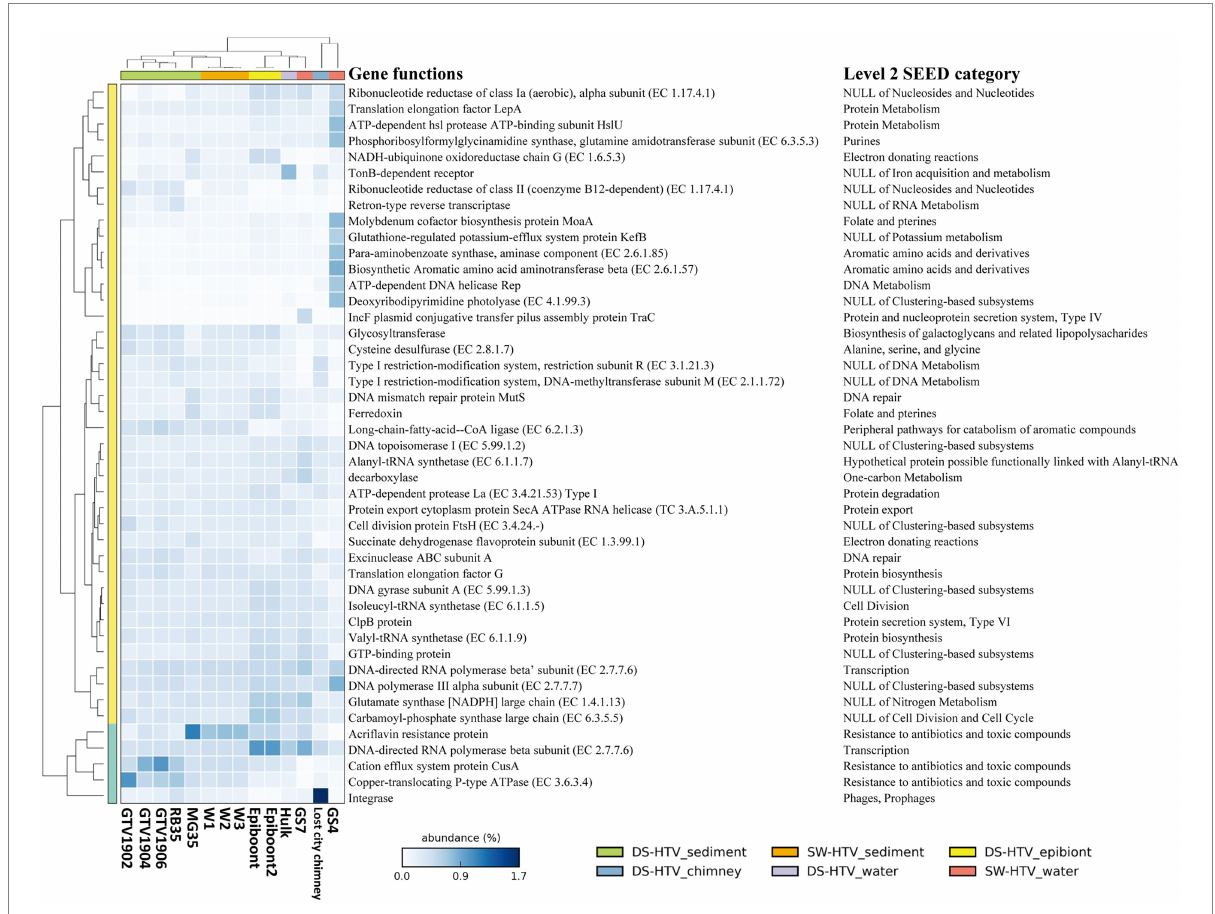
FIGURE 3 The 10 most abundant functions in our data and collected metagenomic datasets form both SW- and DS-HTVs. The dendrogram for the samples (the row) and the function (the column) were cluster by furthest neighbor and average neighbor (UPGMA) method, respectively. The name of level 2 SEED category is also listed for the functional